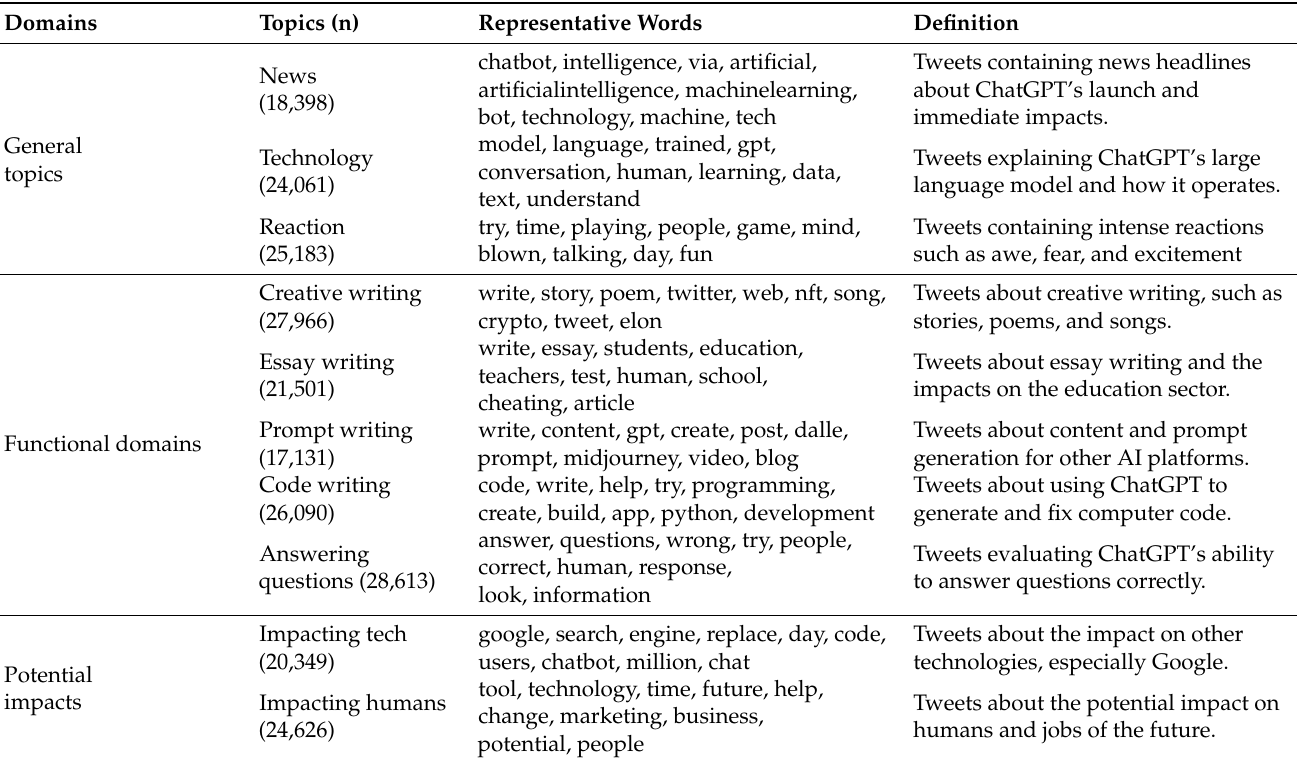
Table 1. LDA results and